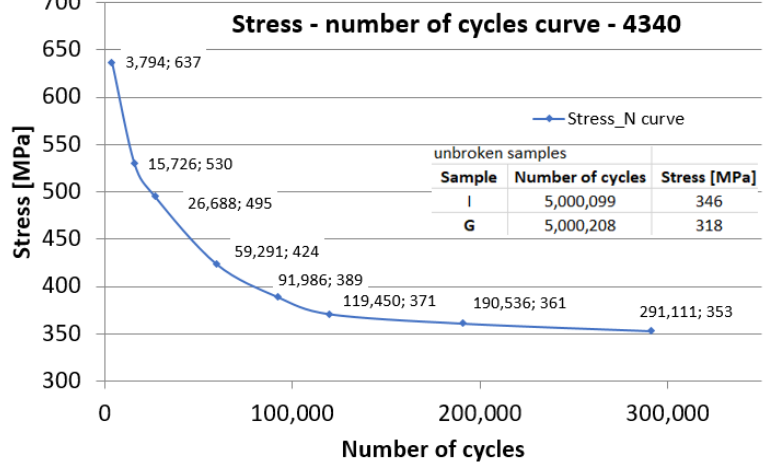
Figure 16. W ӧ hler diagram for fatigue tests of the 4340 steel coated with WIP-C1 powder. Figure 16. Wöhler diagram for fatigue tests of the 4340 steel coated with WIP-C1